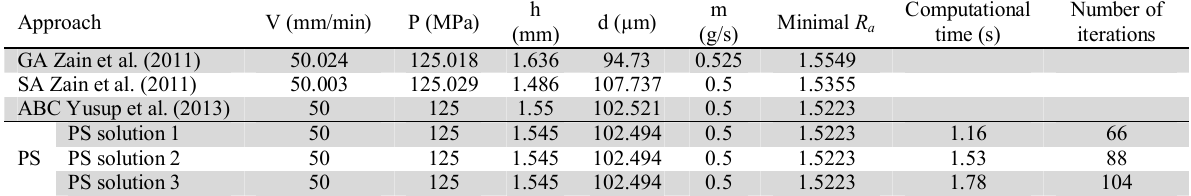
Comparison of optimization solutions for abrasive waterjet machining process Approach V (mm/min) P (MPa) GA Zain et al.